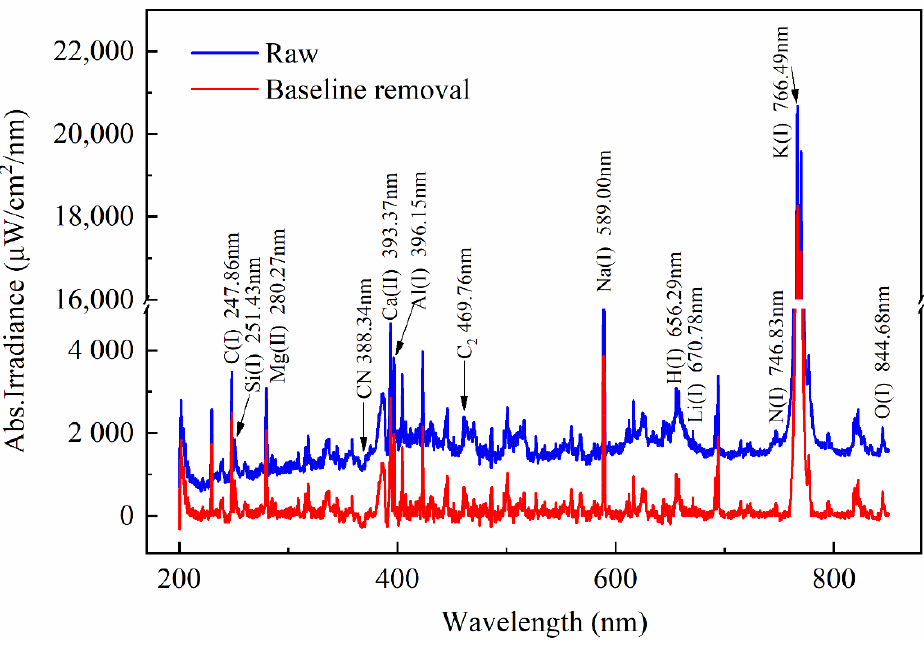
Figure 2. Average emission spectrum of coal sample 1.